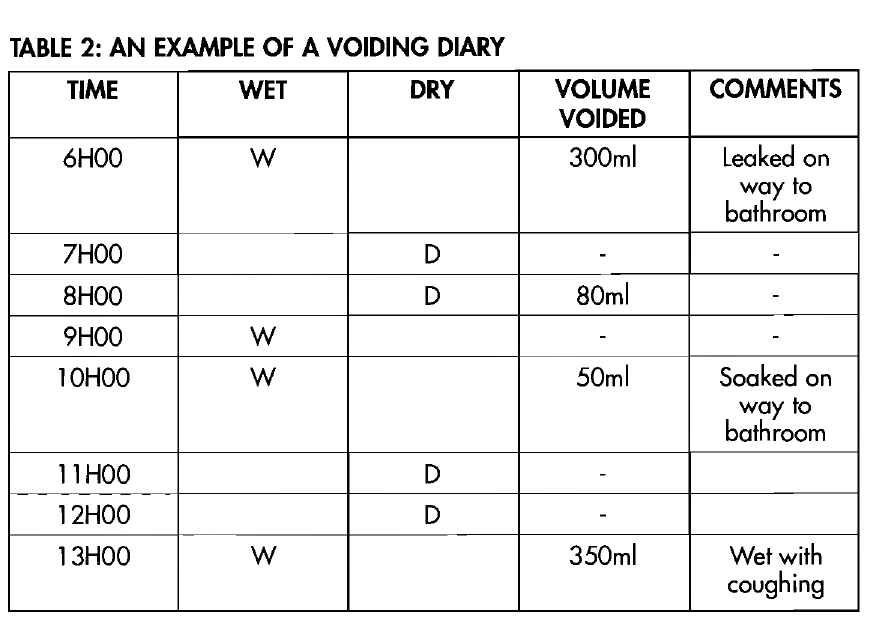
TABLE 2: AN EXAMPLE OF A VOIDING